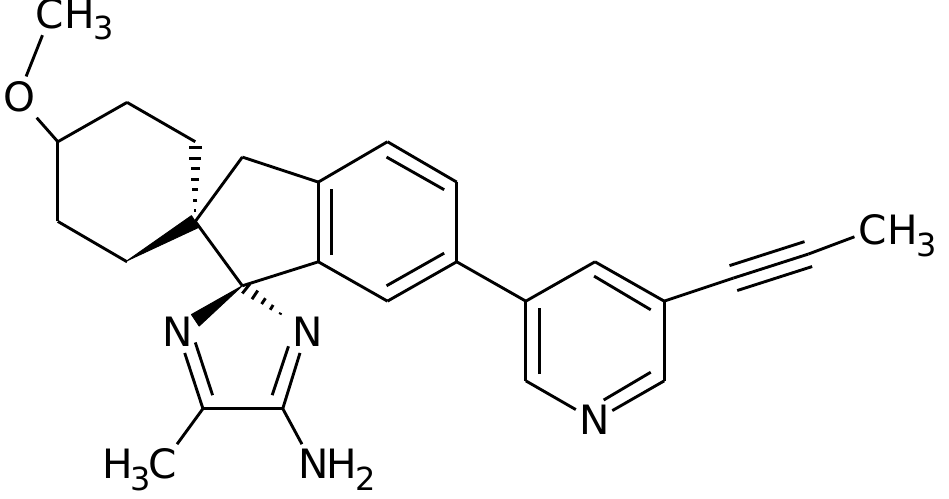
Figure 2. Chemical formula of lanabecestat.